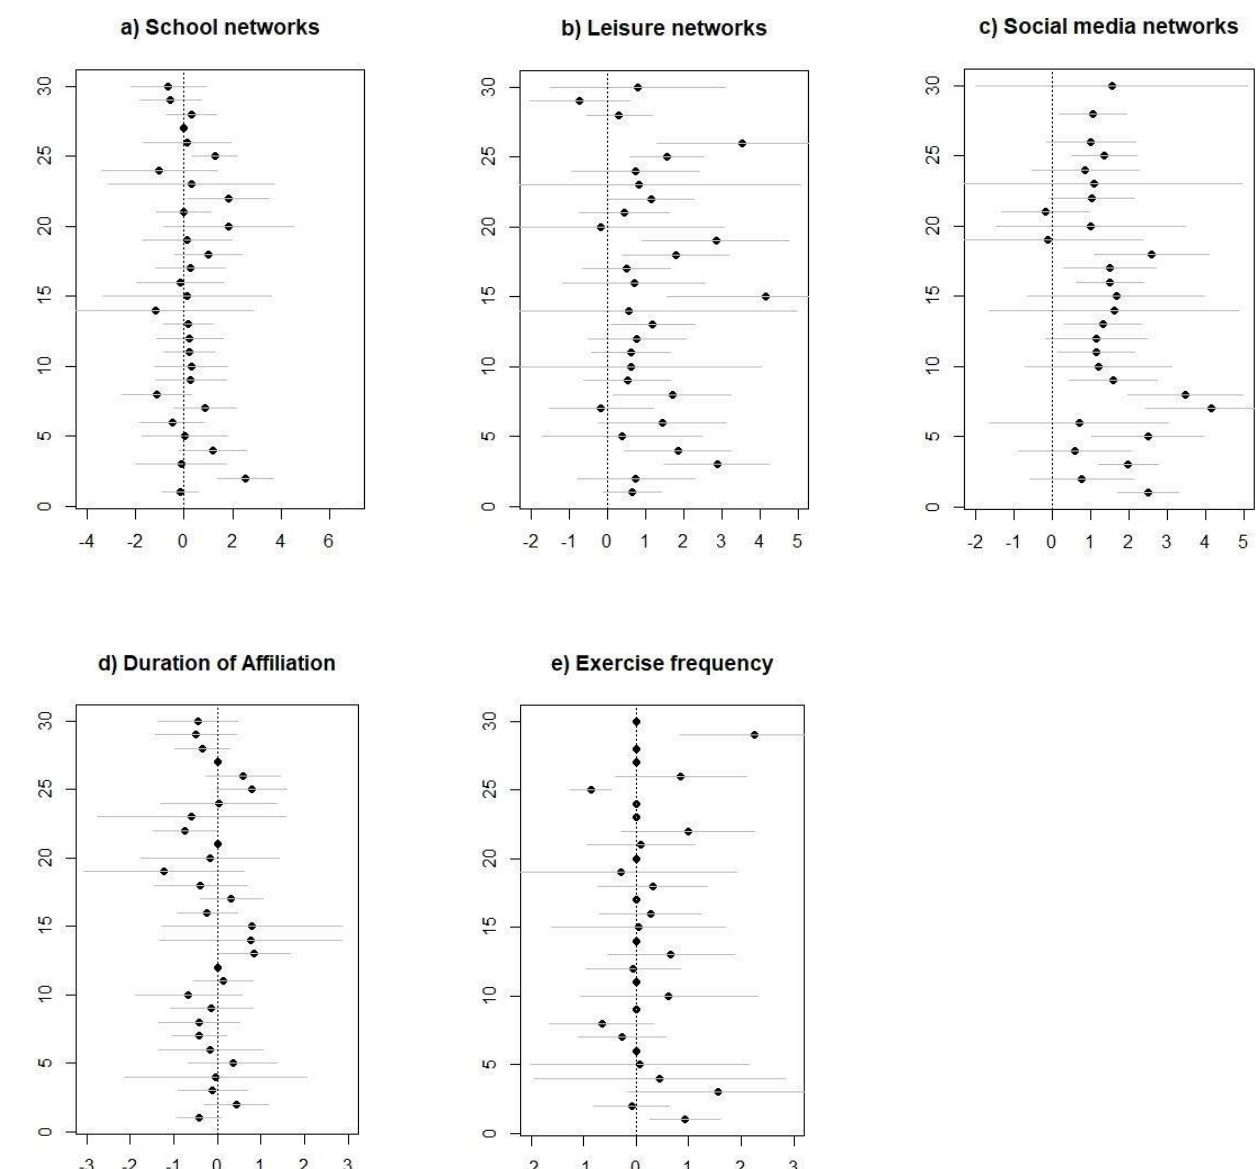
Figure 2. ( a – e ): Coefficients and standard errors (±2) for each of the independent variables in the strong network models. Table 2. Average values for the ERGM coefficients and their standard deviation in the two sport networks.